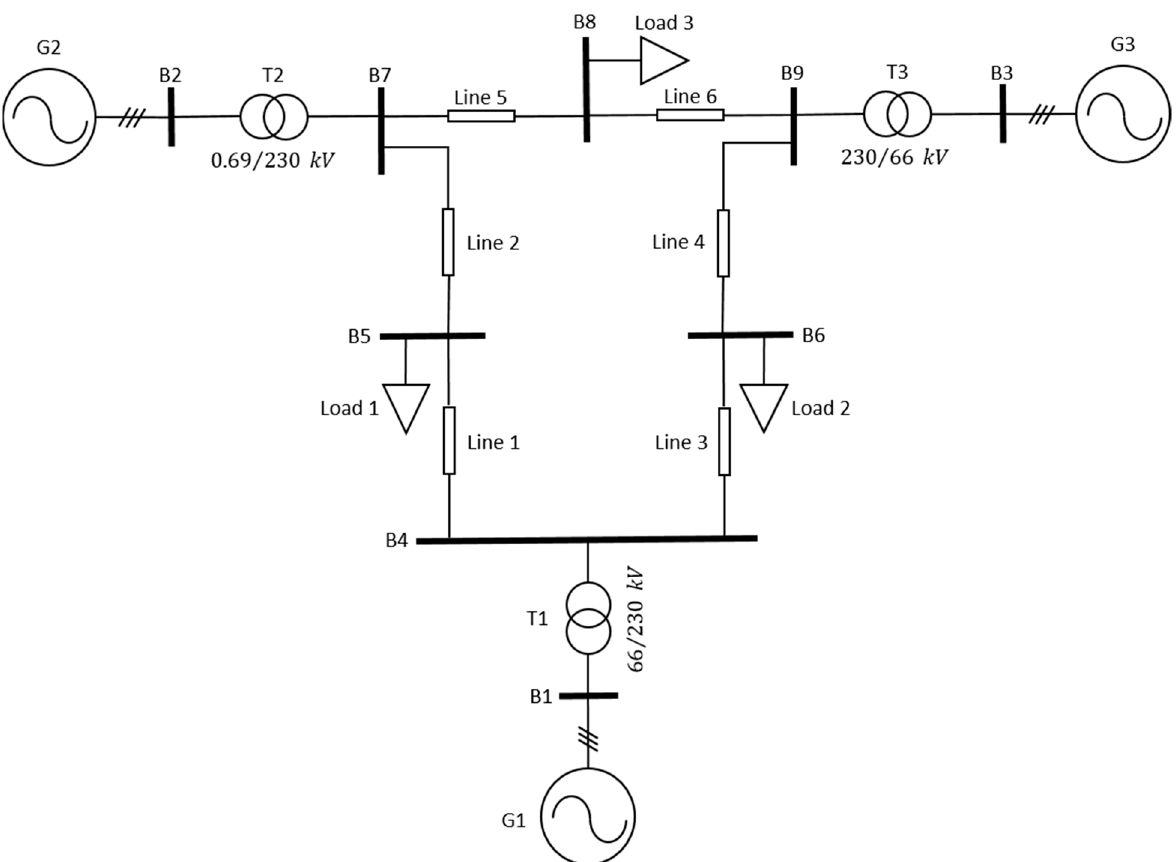
Figure 6. WSCC 9-bus